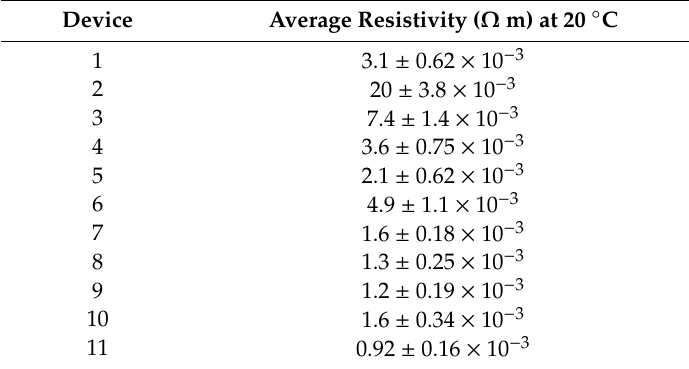
Table 1. The average resistivity of the 11 single G-NS devices calculated from the slopes of five I SD –V SD curves at 20 ◦ C for each